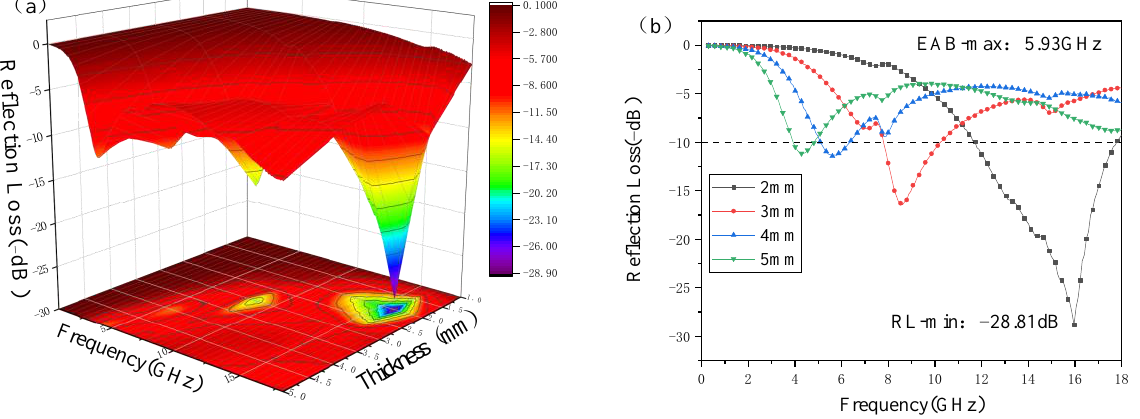
Figure 9. ( a ) 3D theoretically calculated reflection loss (RL) spectra of MWCNT/PA12 composites and ( b ) 2D RL plots.